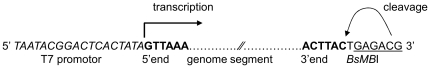
Schematic overview of plasmids containing a full-length BTV genome segment.A full-length BTV genome segment flanked by a T7 promoter and an unique site for a restriction enzyme (here BsmBI is indicated as an example), which defines the BTV 3′end sequence during transcription (depicted from Boyce et al., [18]. The nucleotides of the ultimate 5′- and 3′-ends of the BTV genome segment are presented in bold symbols. The sequence of the T7 promoter is italicized, and that of the unique site is underlined. The positions of the start of transcription and digestion by restriction enzymes for run-off transcription are indicated by arrows.